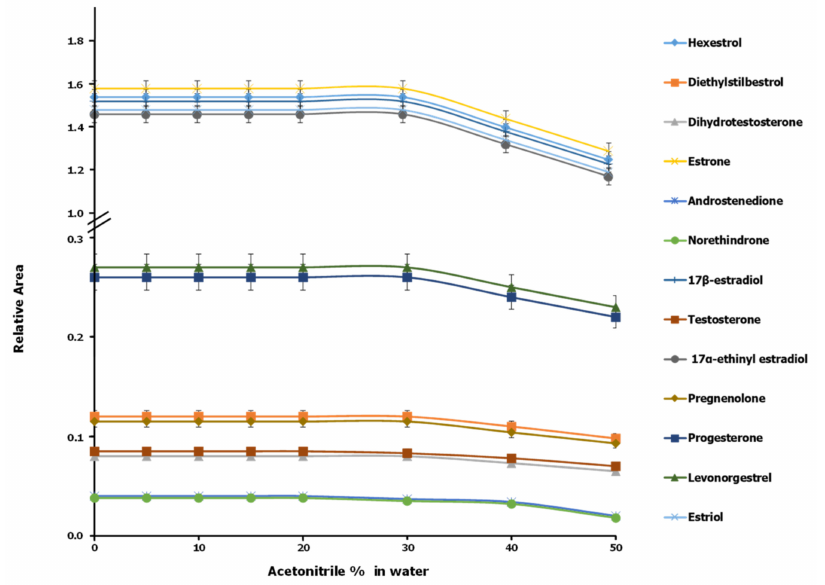
Figure 3. Influence of acetonitrile present in pretreated samples on the sorption efficiency of the continuous SPE system ( n =